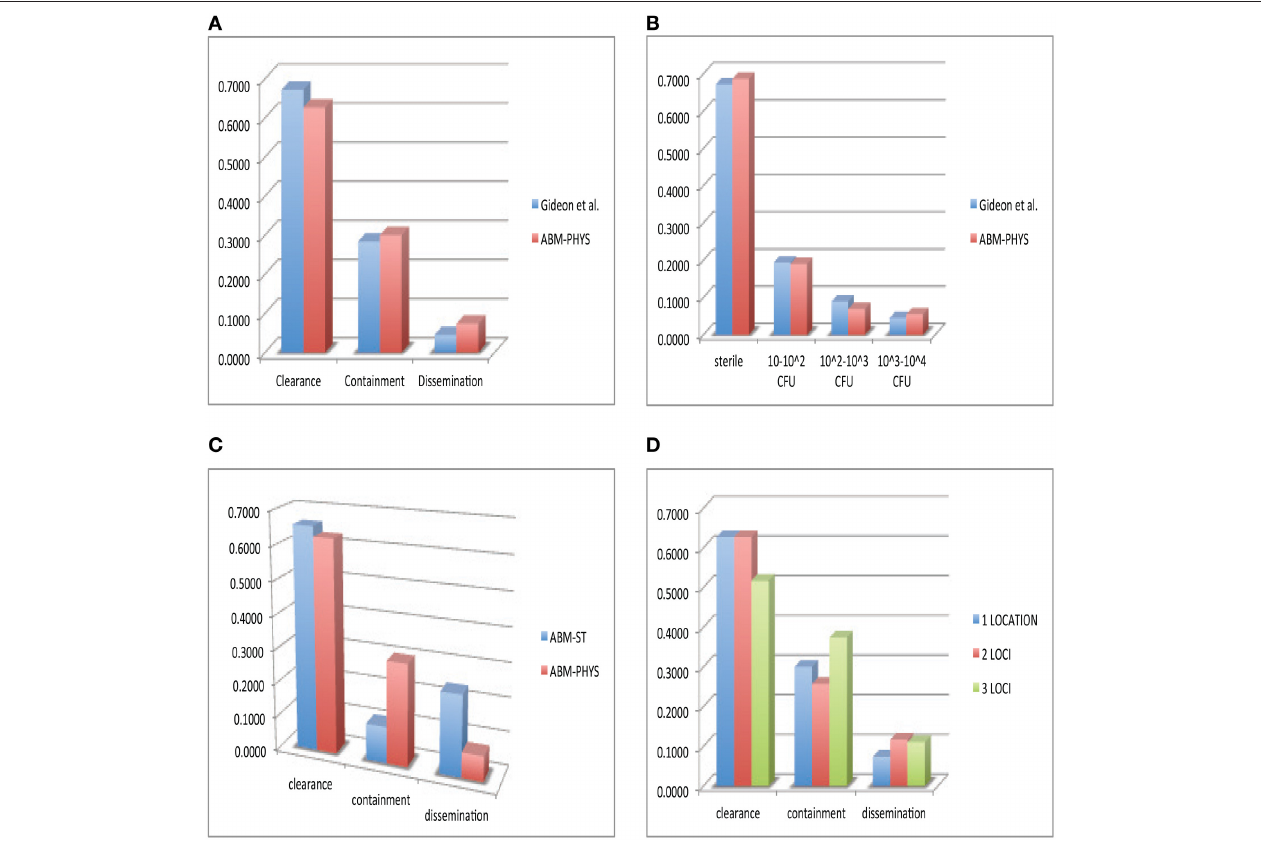
FIGURE 6 | Comparison of in vivo and in silico phenotypic outcomes. Comparison of Gideon et al. (2015) experimental data (blue) and the ABM-PHYS model with oxygen dynamics (red): relative distribution of each qualitative outcome—clearance, containment and dissemination (A) distribution of lesions based on bacterial load (B) comparison of ABM-ST (blue) and the ABM-PHYS model (red) based on the distribution of qualitative outcomes (C) distribution across qualitative outcomes for 1,2, and 3 loci models of the ABM-PHYS model (D) . In silico outcomes based on multisample averages of 300 total